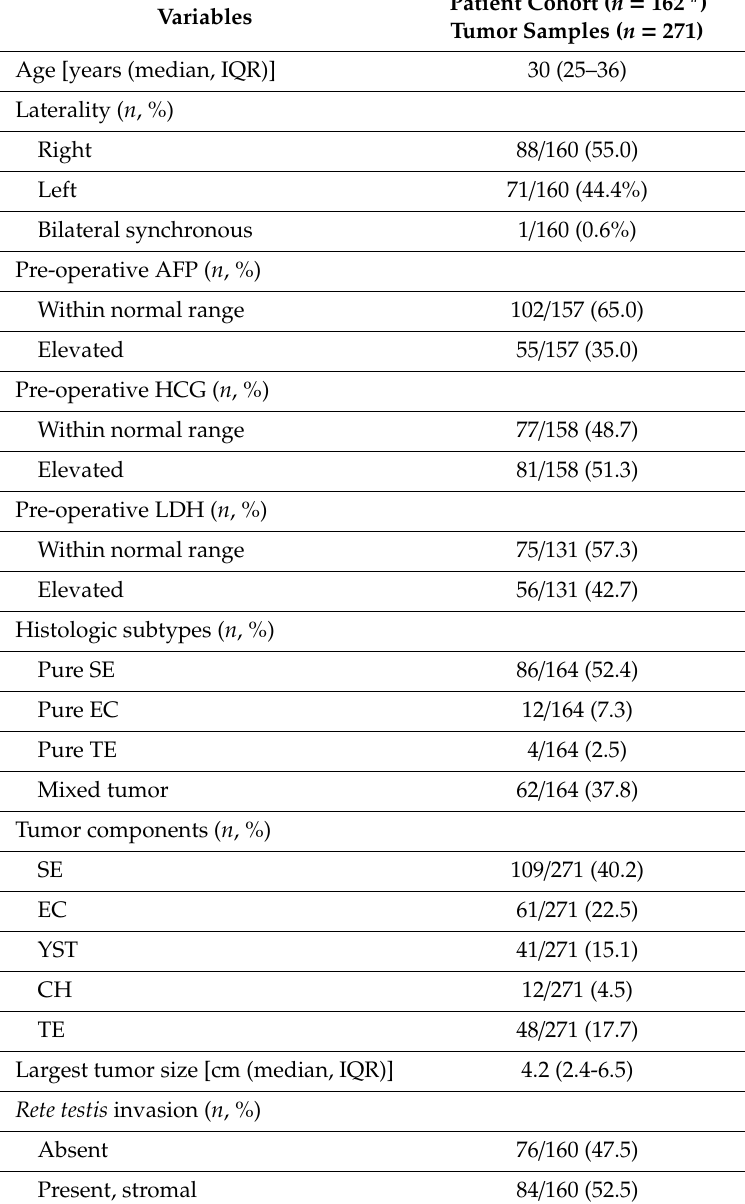
Table 1. Clinicopathological features of testicular germ cell tumor